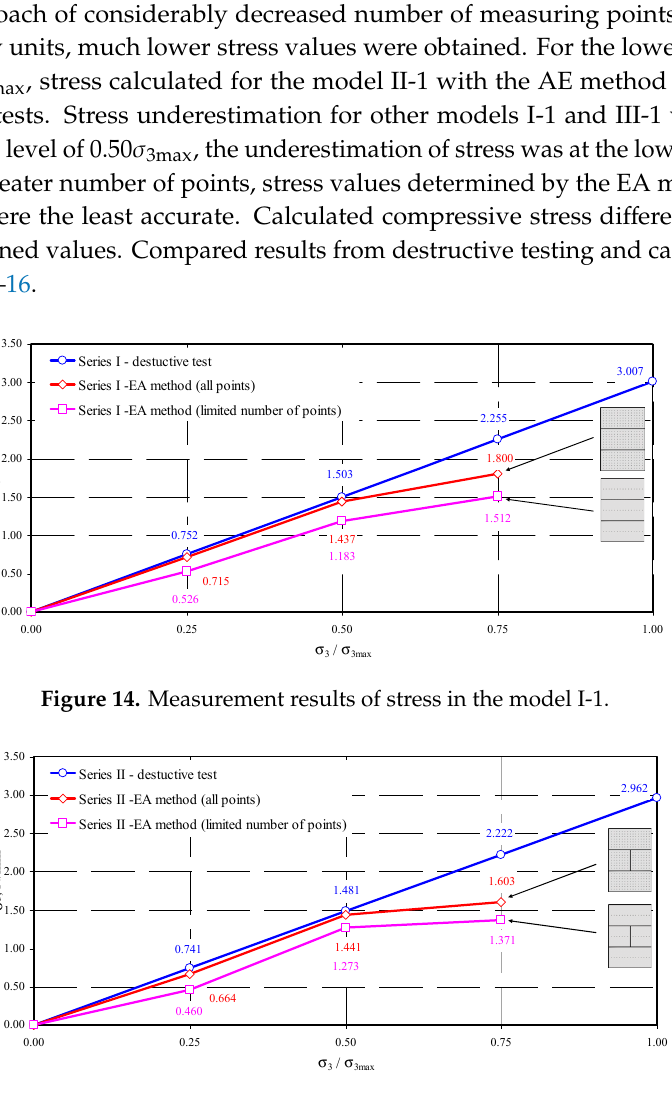
Figure 16. Measurement results of stress in the model III-1. In conclusion, the most favorable results from measuring stress with the calibrated acoustoelastic method were obtained when all measuring points were used at stress levels within the range of 0–0.5 σ 3max . The determined stress values were lower than those from destructive testing small wall models. Considering the approach based on the limited number of points, underestimation of compressive stress was considerably greater. The greatest differences in both methods were found at the stress level of 0.75 σ 3max , which resulted from an increase in effects of ultrasonic wave scattering, developing microcracks in AAC structure (invisible on the external surface of the models). 5.1. Statistical Estimation of Stress in Walls The practical application of that method requires further tests mainly on location of measuring points and their minimal number. However, assuming only measuring points for central area of each masonry unit are used to determine stress in the masonry, then boundary values of strength could be determined with the probability that the obtained results were not lower than experimentally obtained results. Only values from the range of 0–0.5 σ 3max were used for the calculations. The selected range seems to be the most reasonable because at the operational stage force values in real walls can correspond to maximum stress of the order of 50% of the calculated compressive strength of the wall f d . Thus, load-carrying capacity of the real wall [43] depends not on absolute values of compressive force generating stress σ 3 , but on the stability expressed by the reduction factor for load-carrying capacity ( Φ 1,2 and Φ 2m ). Boundary values in confidence intervals of the mean value [53] (at n > 30 and unknown variance σ ) were determined form the general relationship at the statistical significance α = 0.1: